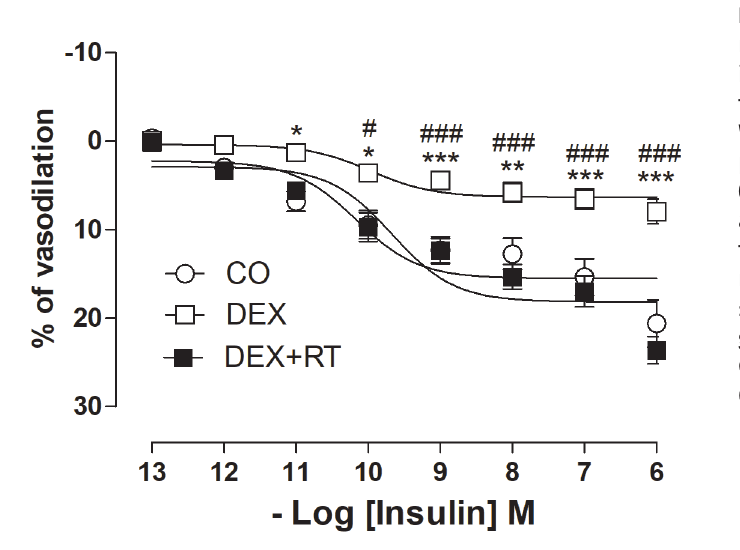
Figure 1. Cumulative concentration- response curve to insulin in intact segments obtained from the superior mesenteric artery of Wistar rats and pre-contracted with phenylephrine (1 μM) in the control (CO), dexamethasone-treated (DEX) and dexamethasone + resistance training (DEX+RT) groups. The results are expressed as the mean ± SEM for 8–10 experiments in each group. *p< 0.05, **p< 0.01 ***p<0.001, CO vs. DEX; # p< 0.05, ## p< 0.01, ### p< 0.001, DEX vs.